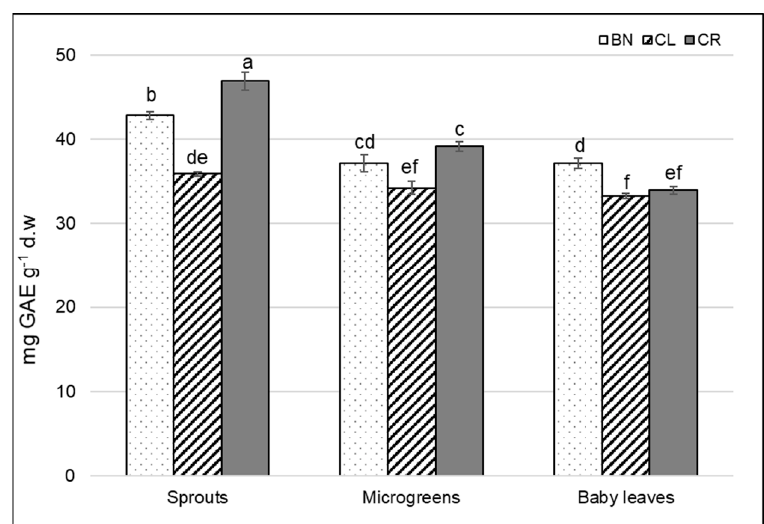
Figure 2. Folin–Ciocalteu index in sprouts, microgreens and baby leaves of BN, CL and CR. Data are reported as mean ± S.E. Bars with the same letters are not significantly different, as determined by Tukey’s test (p < 0.05).